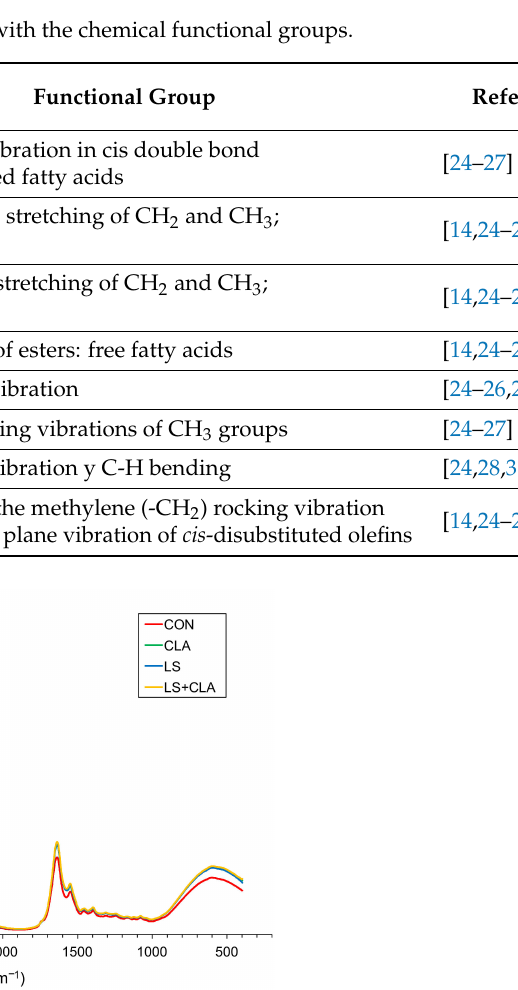
Figure 2. Mean absorbance spectra of 240 beef samples according to the four dietary treatments: CON = control; LS = 10% linseed; CLA = 2% conjugated linoleic acid; LS+CLA.